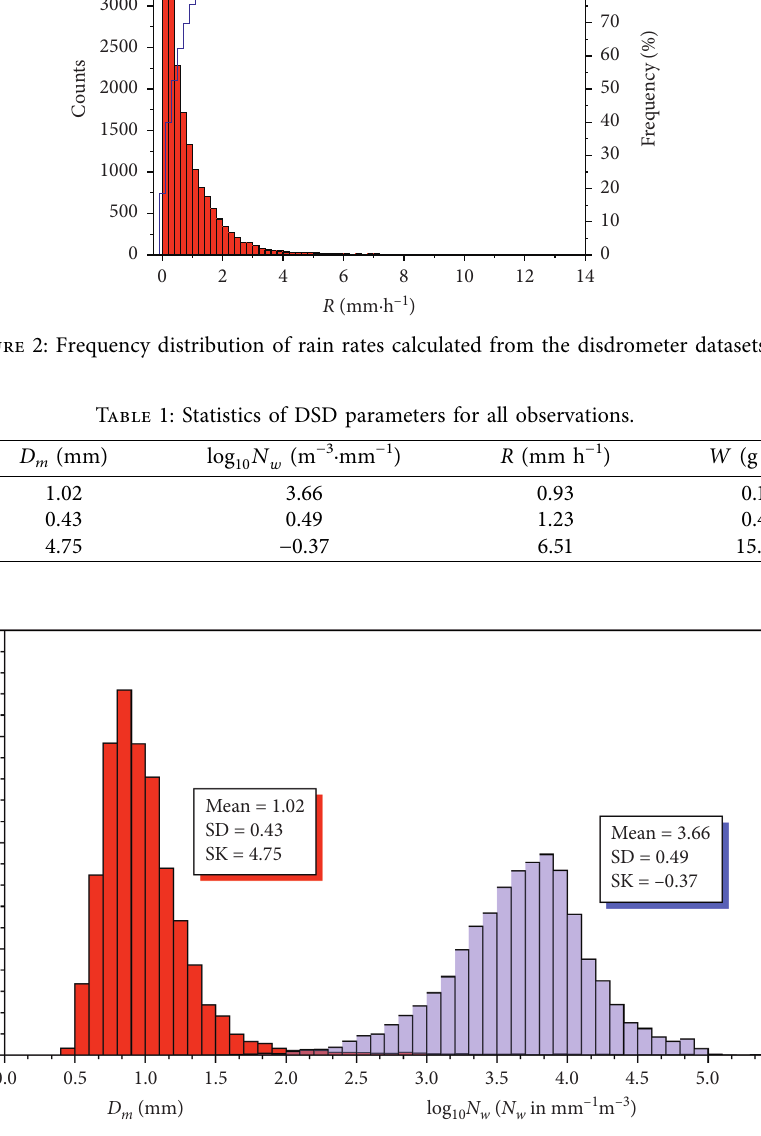
Figure 3: Histograms of D N m and log 10 w for all observations. Mean values, standard deviation (SD), and skewness (SK) are also given in each plot.